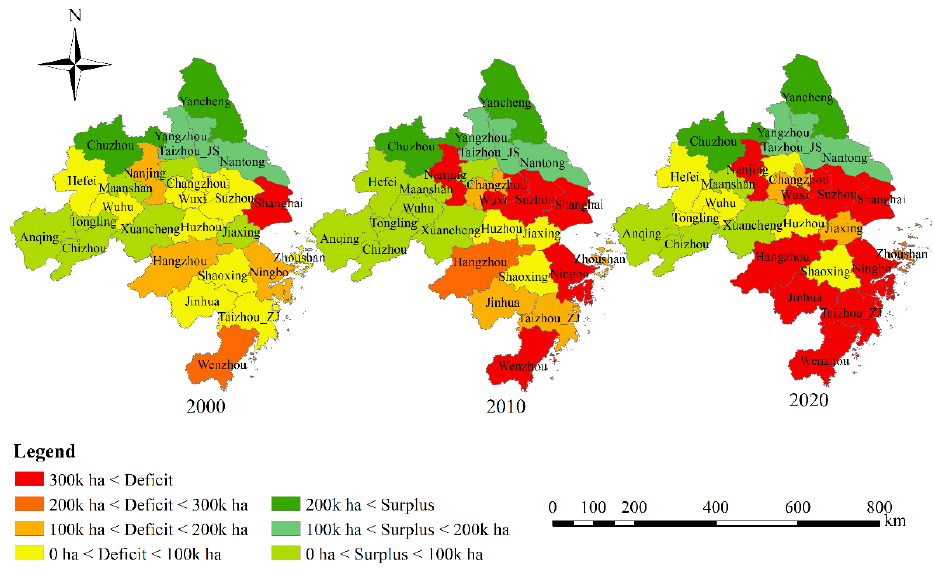
Figure 8. Spatial distribution of farmland-surplus cities and farmland-scarce cities.